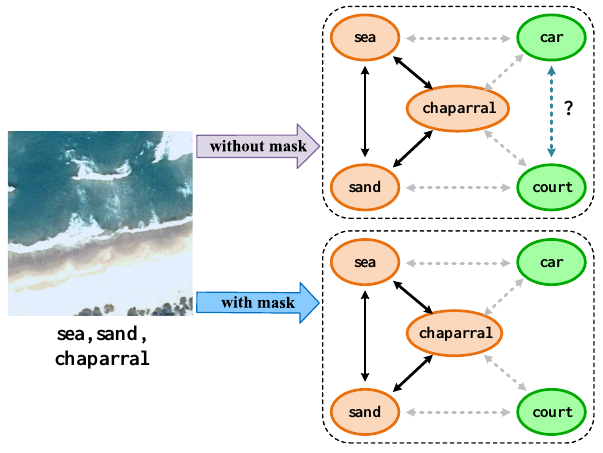
Figure 1. Illustration of the effect of mask